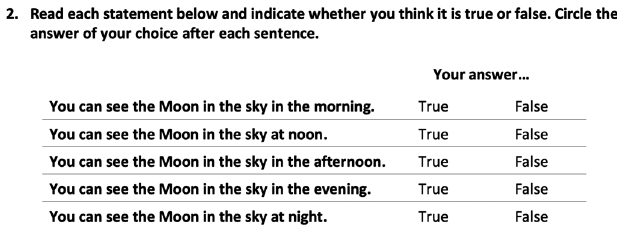
FIG. 2. Item 2 of the MPCI-MS: True-or-false question about the visibility of the moon by day and by night.